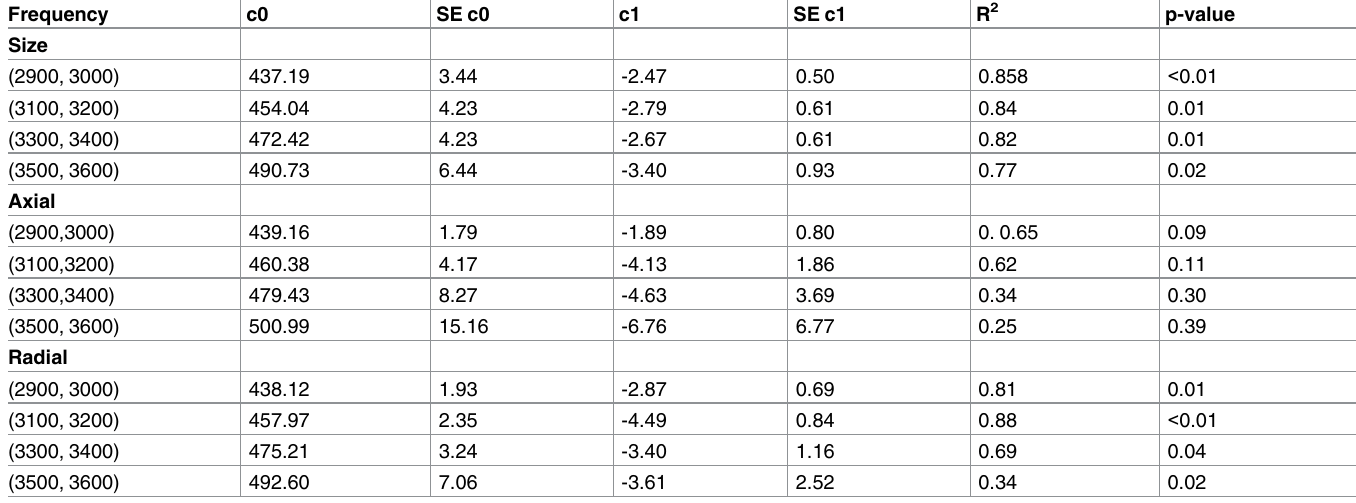
Table 2. Optimized parameters, standard errors (SE), and statistics for the phase velocity as determined by weighted linear regression c = c1 (cid:1) porosity + c0. Frequency